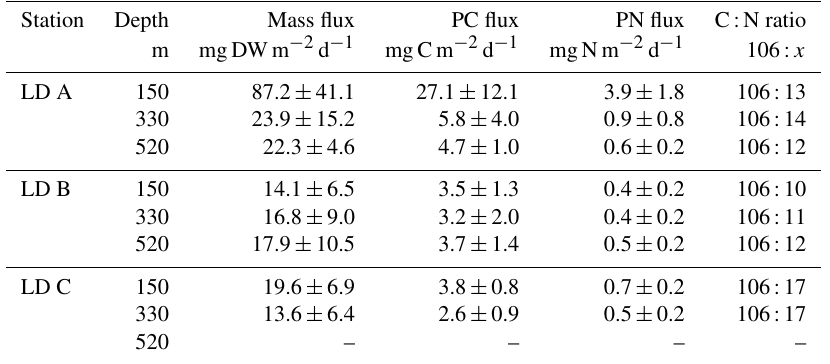
Table 1. Sediment trap data at the three LD stations. Depth of collection, mean mass flux of dry weight (DW) matter, particulate C and N flux, and mean C:N molar ratio. No data were collected at LD C at